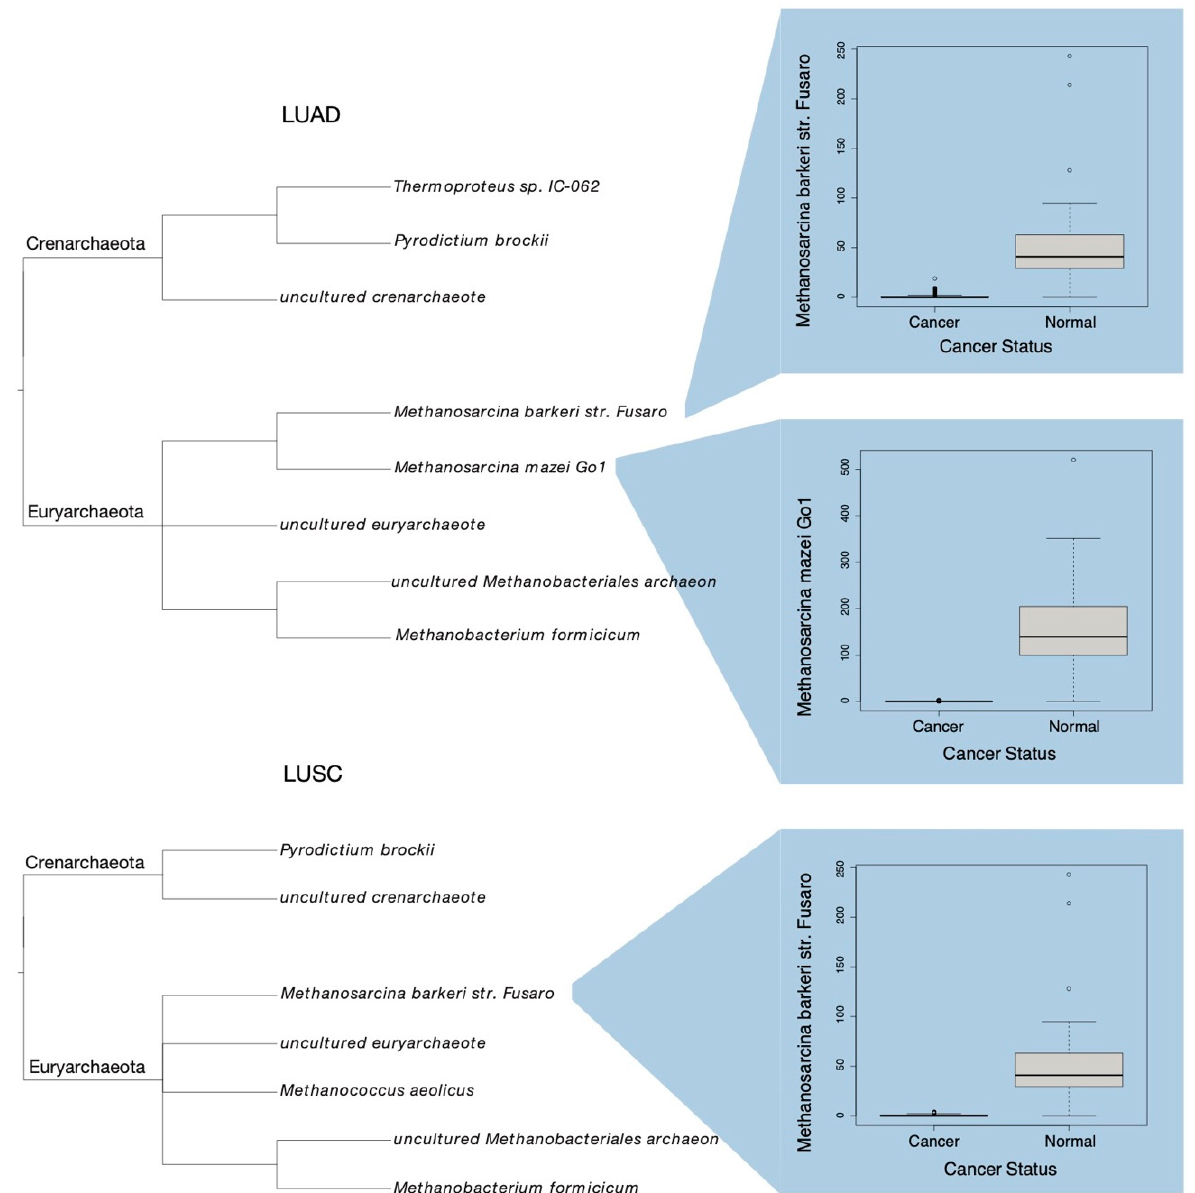
Figure 2. Phylograms of species differentially abundant in LUAD and LUSC samples, as compared to normal adjacent samples. Respective taxonomic phylums are shown. Select box plots of species abundance in cancer samples versus normal samples.